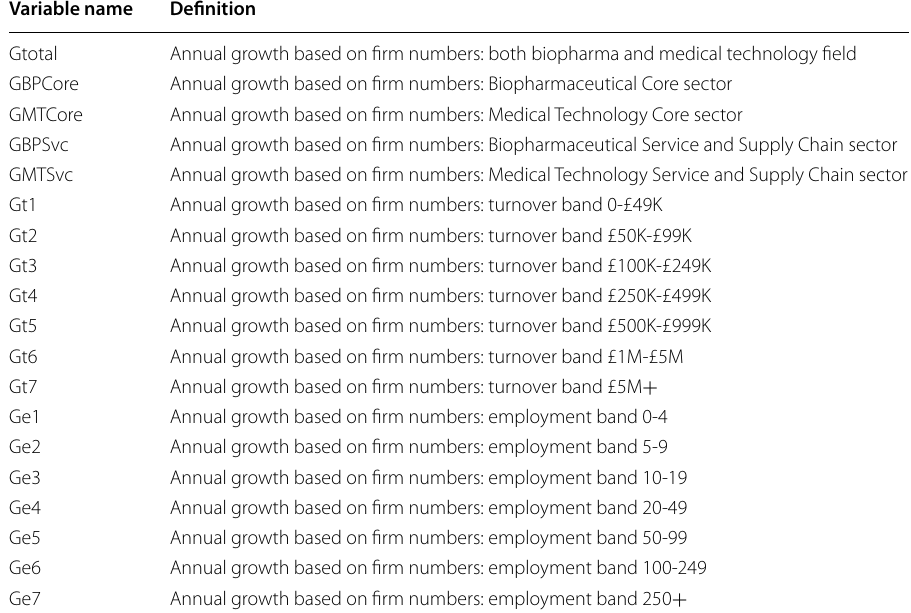
Table 3 Variables and definitions: Annual firm number growth